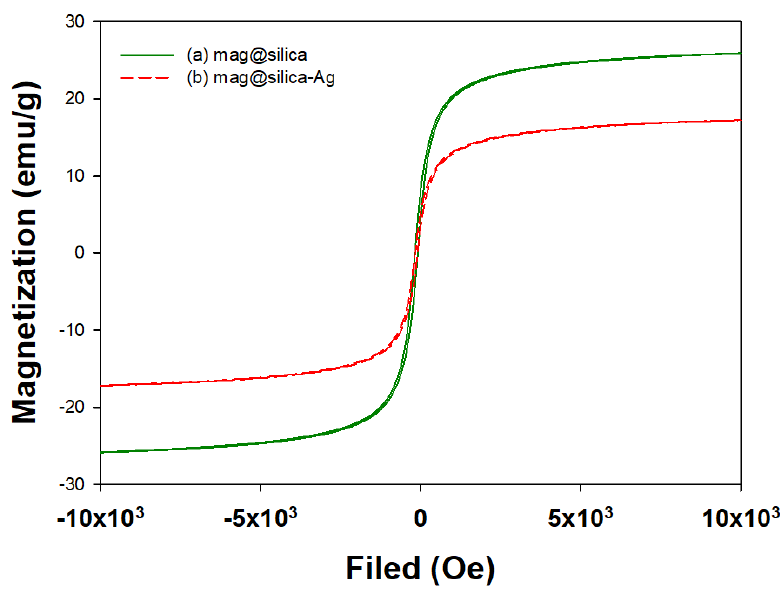
Figure 10. Magnetization curves for ( a ) mag@silica and ( b ) mag@silica-Ag.